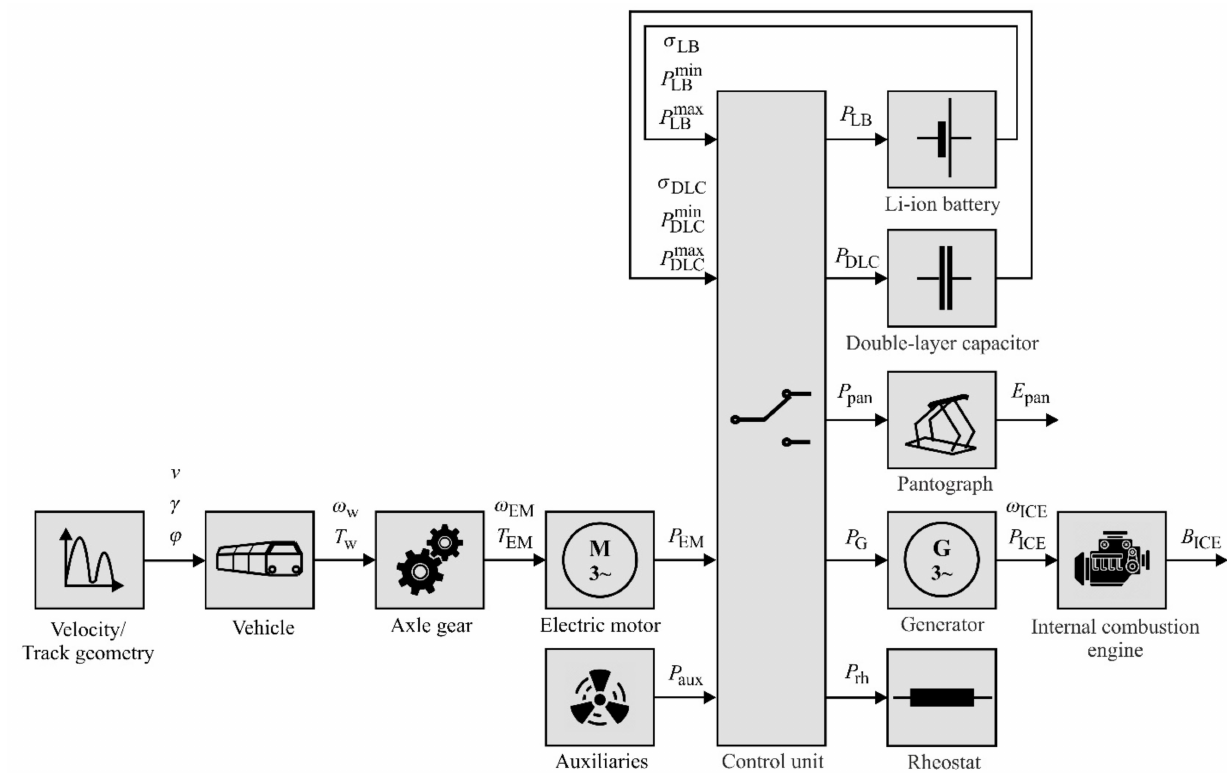
Figure 2. Layout of the simulation model for the assessment of the alternative diesel-electric multiple-unit propulsion system